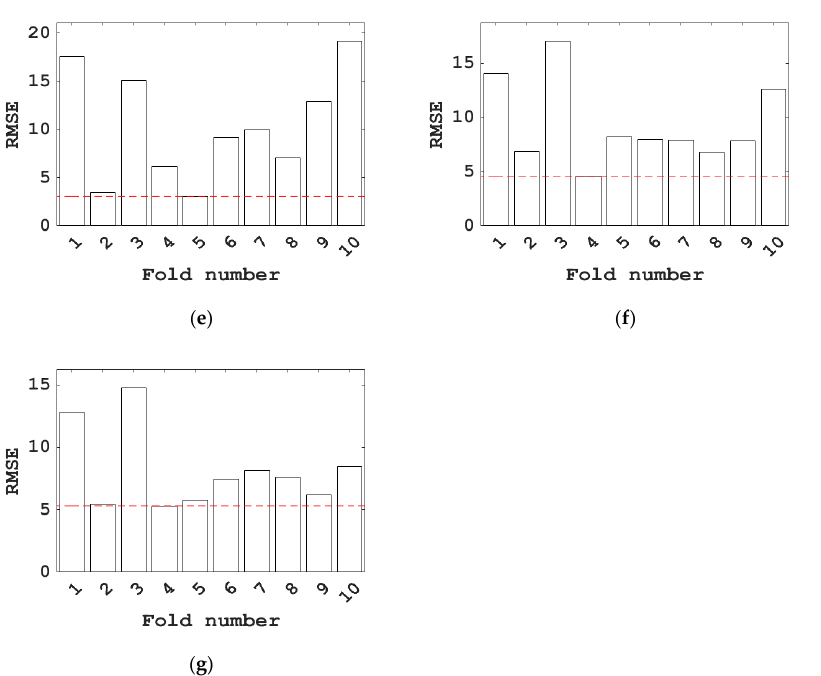
Figure 8. RMSE values for different fold numbers of different models. ( a ) BPNN; ( b ) SVM; ( c ) DT; ( d ) RF; ( e ) KNN; ( f ) LR; ( g ) MLR (Red lines represent the minimum values of RMSE).